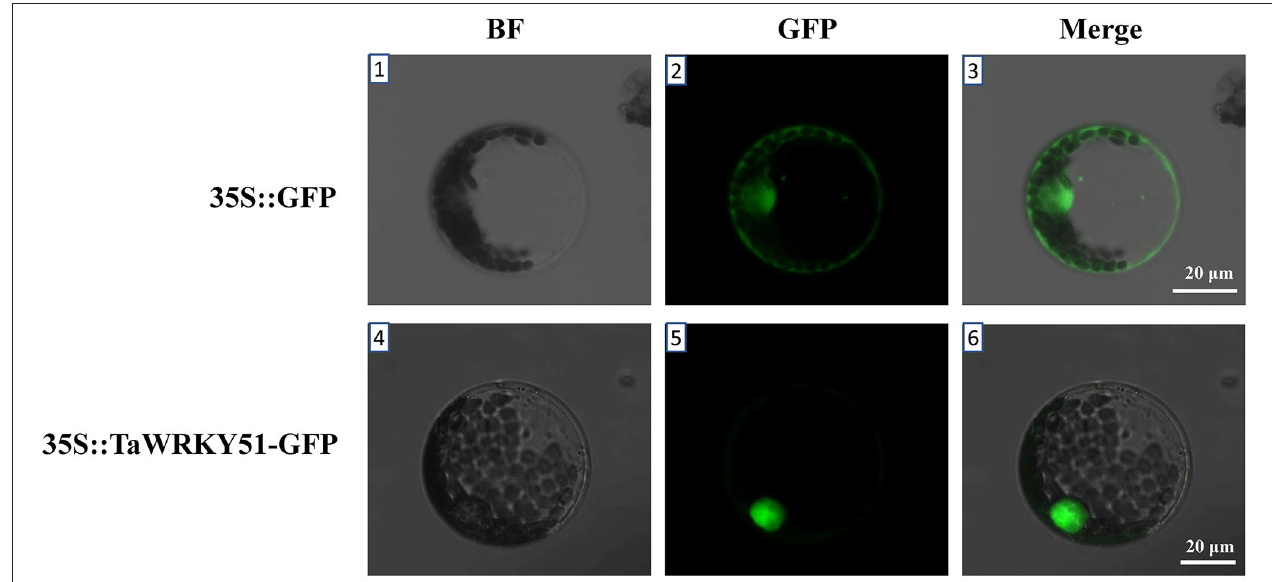
FIGURE 3 | TaWRKY51 specifically locates in the nucleus of the wheat protoplast. The constructs 35S::TaWRKY51-green fluorescent protein (GFP) and 35S::GFP were transformed into wheat protoplast by polyethylene glycol (PEG)-mediated method respectively. 1–3, wheat protoplast expressing GFP as a control. 4–6, wheat protoplast expressing TaWRKY51-GFP fusion protein. The pictures were taken in bright and black fields 36h after transformation by a laser scanning confocal